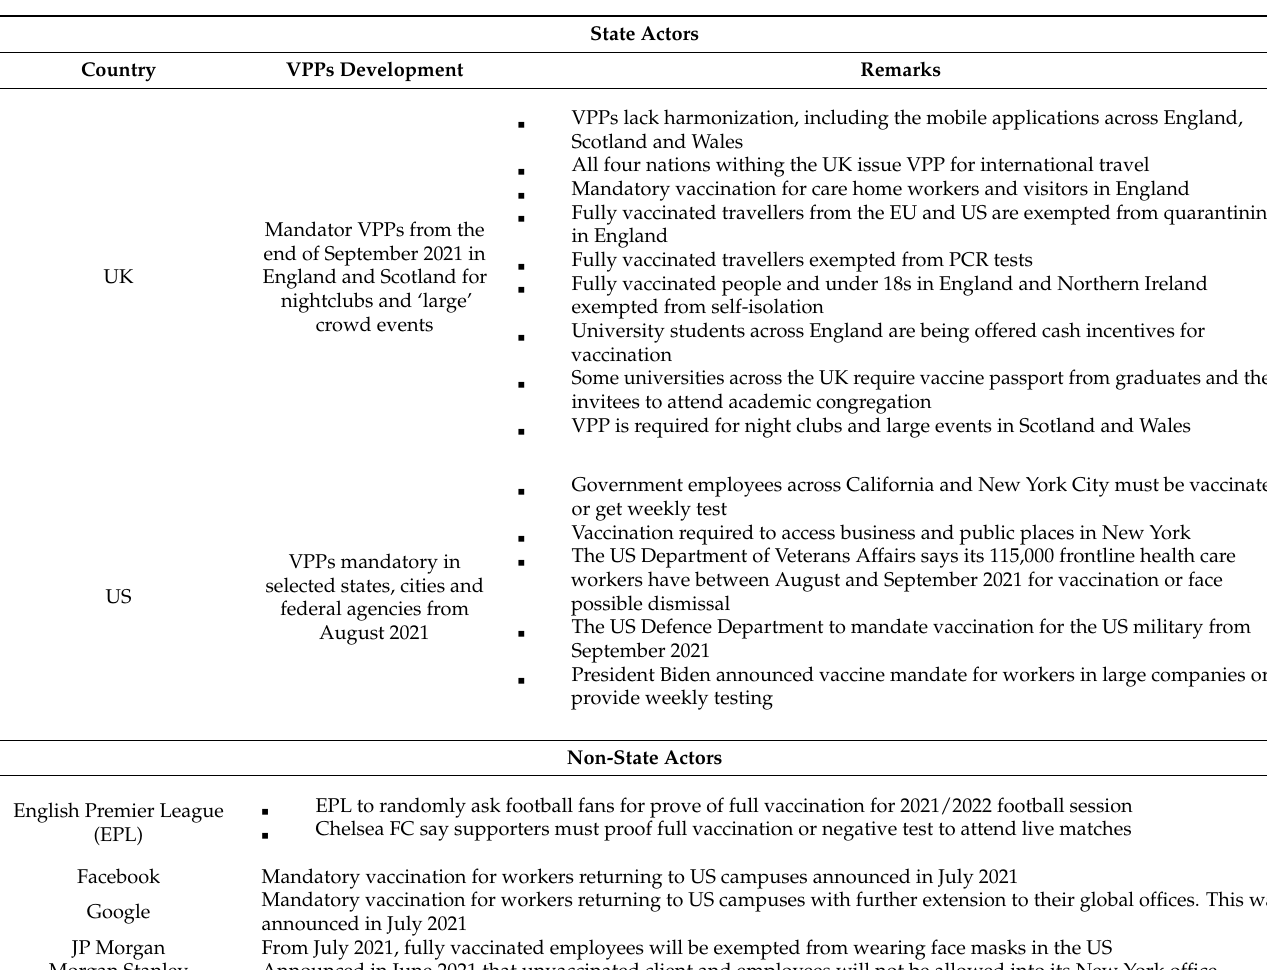
Table 1. Examples of state and non-state actors implementing/planning vaccine passport policies (VPPs).